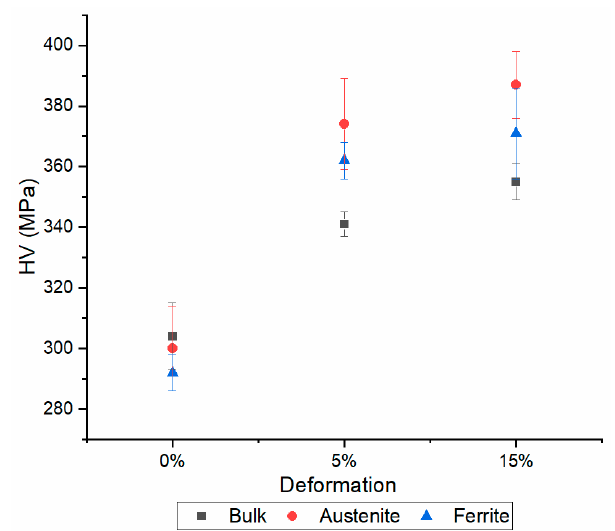
Figure 7. Microhardness evolution as a function of prestrain of the bulk material and of each phase.